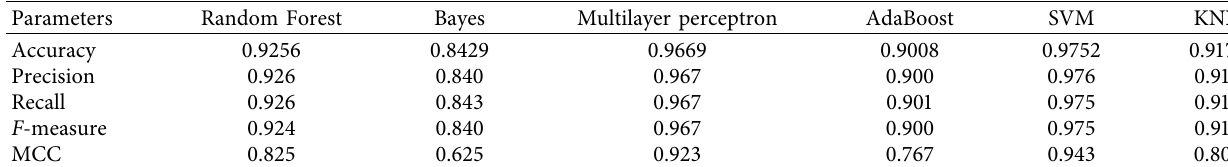
Table 3: Classification accuracy based on texture and color feature extraction.